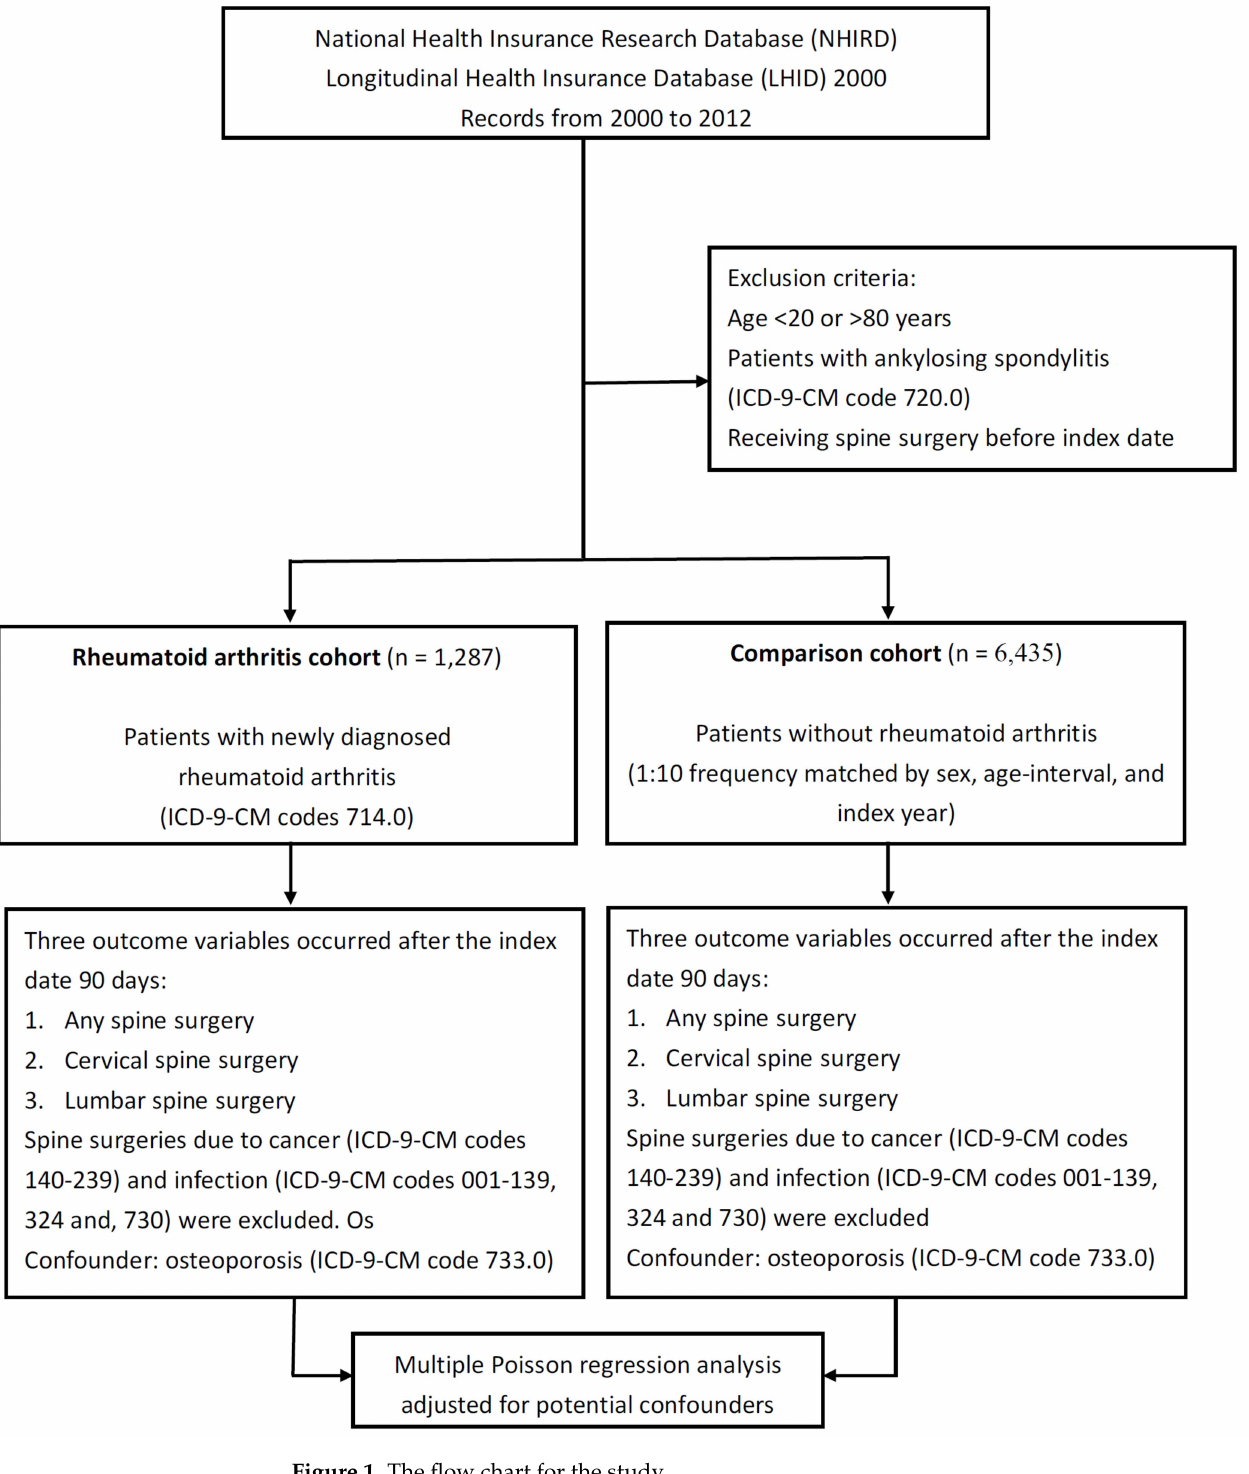
Figure 1. The flow chart for the